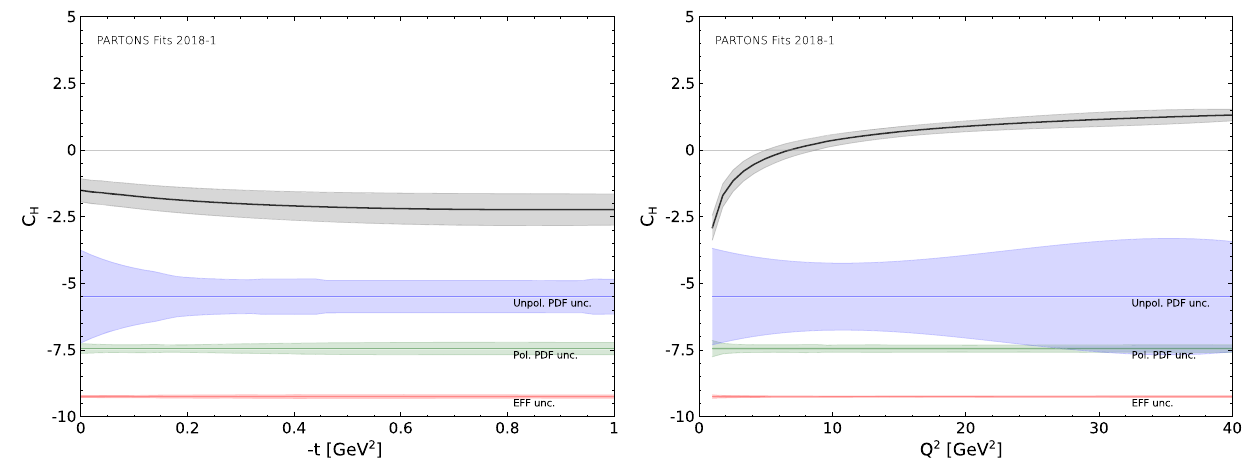
Fig. 10 Subtraction constant obtained in this work as a function of t at Q 2 = 2 GeV 2 (left) and as a function of Q 2 at t = 0 (right). For further description see Fig. 6